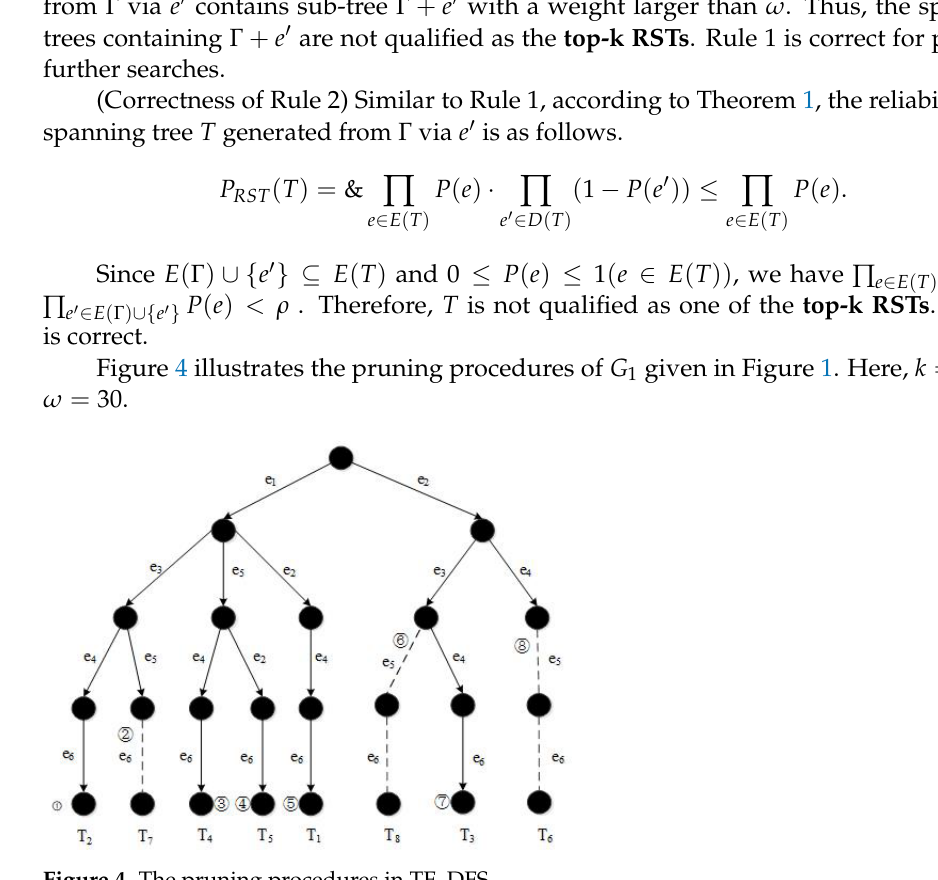
Figure 4. The pruning procedures in TF_DFS. In Figure 4, the solid lines represent the recursive procedures of a depth-first search.